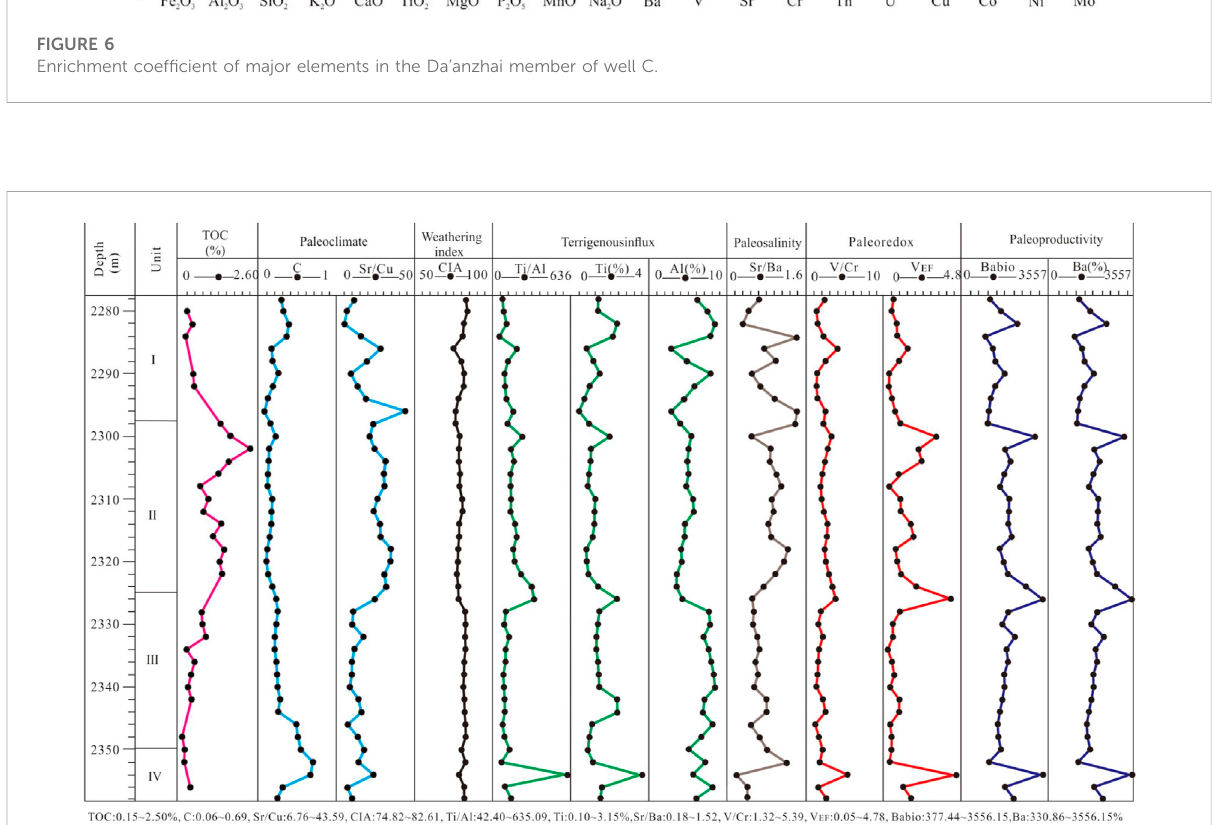
FIGURE 7 Paleoenvironment parameter in the Da ’ anzhai member of well